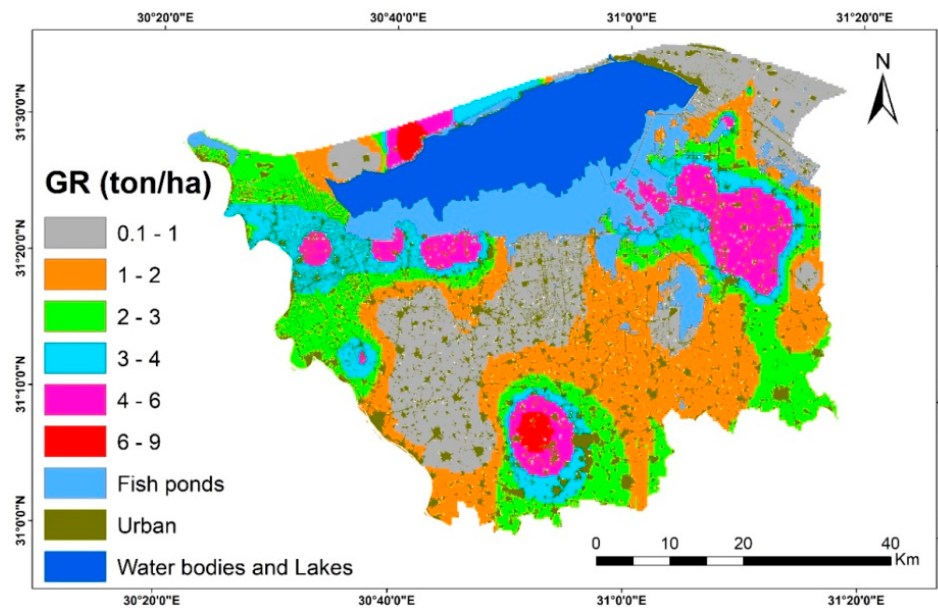
Figure 7. Different gypsum requirement assessments by GIS for the study area.